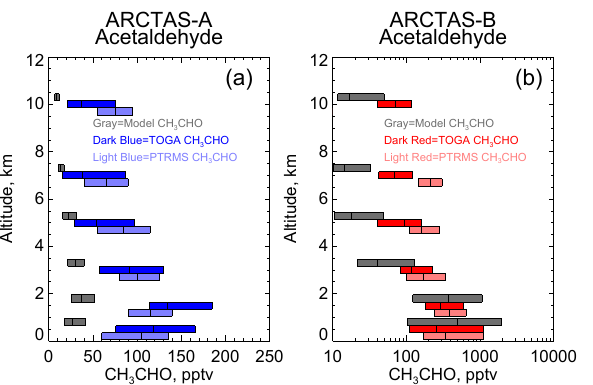
Fig. 20. Altitude profiles of observations and model predictions of acetaldehyde during (a) ARCTAS-A and (b) ARCTAS-B. Bar plots are as described in Fig. 2.